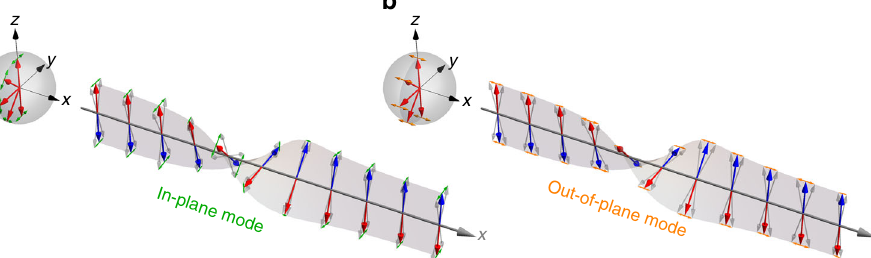
Fig. 1 Schematics of an antiferromagnetic domain wall with its in-plane and out-of-plane modes. The domain wall pro fi le is indicated by the thick red/blue arrows for the two sublattices. The Bloch sphere on the left shows that the magnetization m 1 ( red arrow ) in a domain wall traces a longitude on a Bloch sphere in the y – z plane from north pole to south pole . The green (at a ) and orange (at b ) arrows indicate the the in-plane (at a ) and out-of-plane (at b ) spin wave excitations upon a Bloch type antiferromagnetic domain wall. The in-plane and out-of-plane modes oscillate along longitude and latitude on the Bloch sphere, and they are connected to linear y -polarization and x -polarization inside domains (where m i ^ z k ),